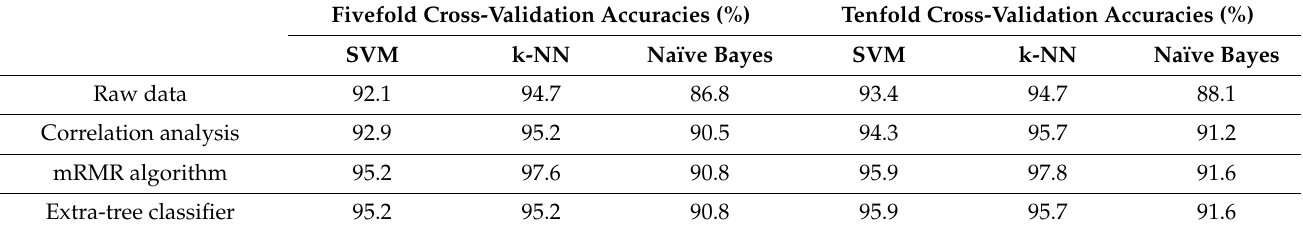
Table 5. Comparison of fivefold and tenfold cross-validation accuracies for the boiler water wall tube leakage detection scenario. Fivefold Cross-Validation Accuracies